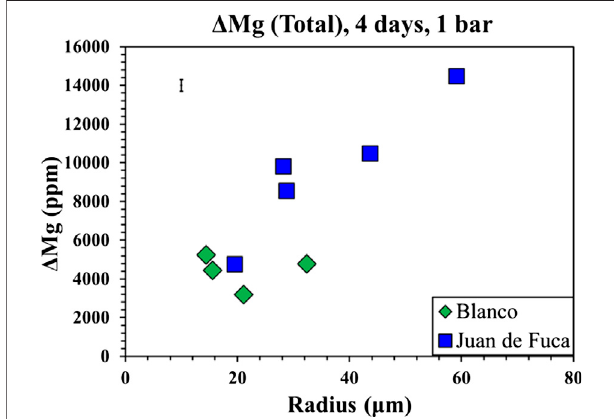
FIGURE 8 | The change in Mg between individual 4-day MIs and the averaged 30-min Mg value plotted against radius. Blue squares represent 4- day low pressure Juan de Fuca samples, whilethe green diamonds represent 4-day low pressure Blanco Fracture Zone samples. The plot shows an increase in the change in Mg with increasing MI